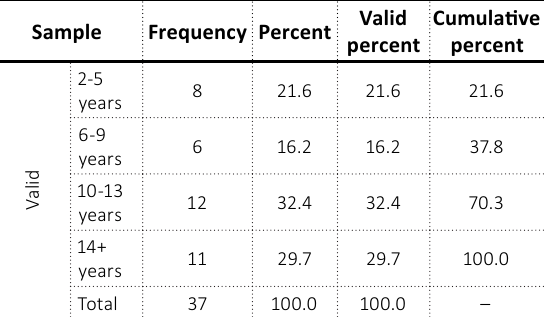
Table 2. Sample characteristics